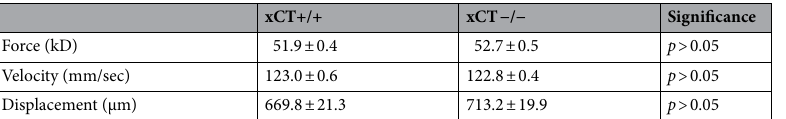
Table 1. Parameters recorded after computer-controlled SCI contusion. Data are expressed as mean ±